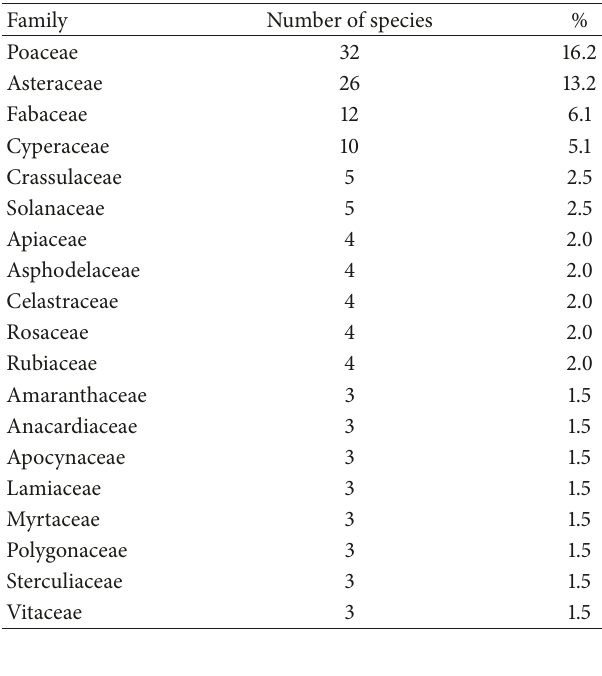
Table2:Plantfamilieswiththelargestnumberofspecies(withmore than 3 species) in the Ntabelanga catchment area.